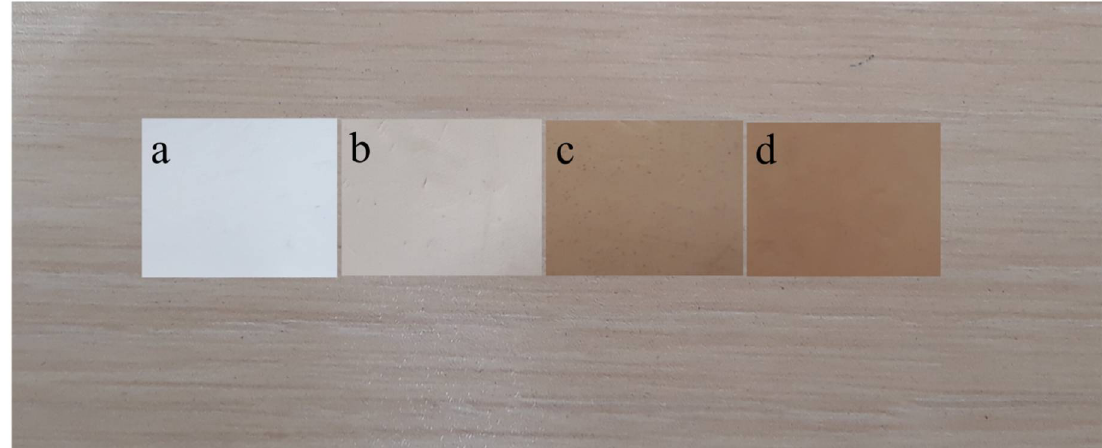
Figure 4. PCL and nanocomposite PCL fibrous scaffold membranes, ( a ): PCL, ( b ): 3MNP, ( c ): 5MNP, and ( d ): 10MNP.